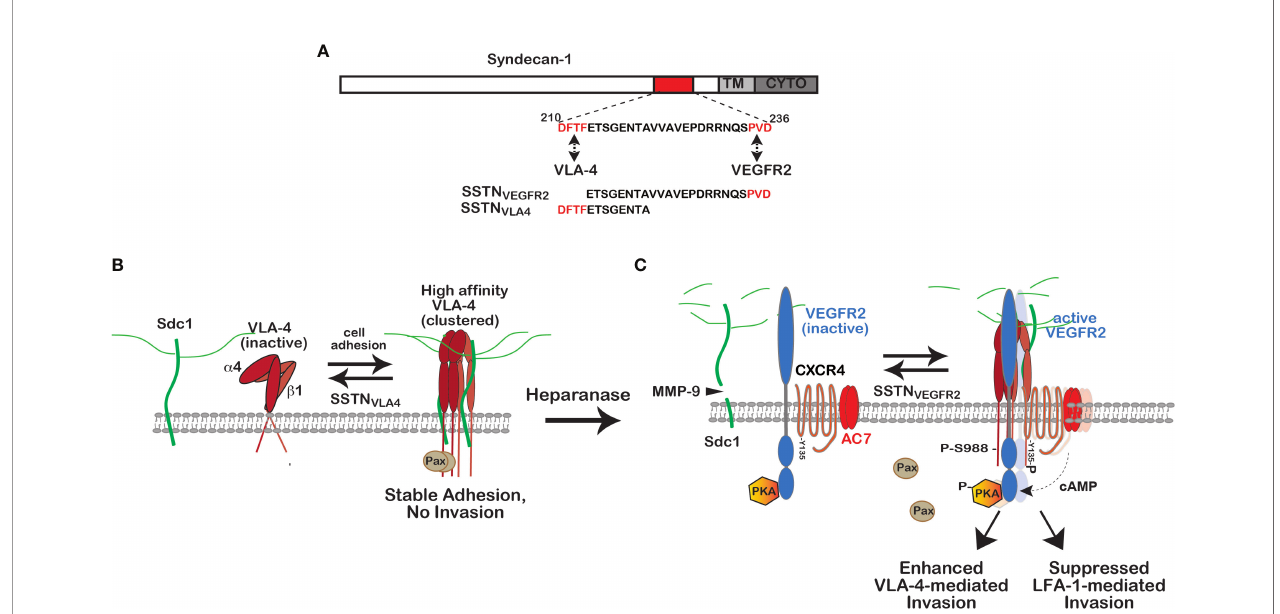
FIGURE 2 | Regulation of VLA-4 activation and polarized cell invasion by Sdc1. (A) VLA-4 and VEGFR2 docking sites in Sdc1. Juxtamembrane sites in the extracellular domain of human Sdc1 (DFTF and PVD) responsible for engaging very late antigen-4 (VLA-4, a 4 b 1 integrin) and vascular endothelial growth factor receptor-2 (VEGFR2), respectively. Synstatin peptides containing one, but not both of these sites (e.g., SSTN VLA-4 or SSTN VEGFR2 ), prevent VLA-4 or VEGFR2 capture by the syndecan and disrupt signaling that relies on the co-capture of both receptors. (B) Regulation of high af fi nity VLA-4 adhesion by Sdc1. VLA-4 undergoes rapid activation when engaging ligand, involving a conformation change and clustering (avidity modulation) to increase binding af fi nity. On cells expressing Sdc1 (e.g., myeloma cells, vascular endothelial cells, melanoma, Jurkat-T cells), this activation is blocked by preventing VLA-4 docking with Sdc1 using SSTN VLA-4 or mutating the DFTF motif in the syndecan. The mechanism underlying this dependence on the syndecan remains under investigation. (C) Role of heparanase and shed Sdc1 in polarized cell invasion . The heparan-sulfate-degrading enzyme heparanase is a known tumor promoter and enhancer of leukocyte recruitment during in fl ammation. Trimming of the HS chains on Sdc1 exposes its core protein to cleavage by matrix-metalloproteinase-9 (MMP-9), releasing the syndecan ectodomain. The shed syndecan couples an inactive receptor complex consisting of VEGFR2 with inactive protein kinase A (PKA) attached to its cytoplasmic domain, the cytokine receptor CXCR4 and adenylate cyclase 7 (AC7) to the clustered integrin, causing VEGF-independent activation of VEGFR2; VEGFR2 phosphorylates CXCR4 on Y135, activating its G a i bg GTPase and the G a i -dependent AC7. Local generation of cAMP leads to activation of protein kinase-A (PKA) engaged with the VEGFR2 cytoplasmic domain and phosphorylation of the a 4-integrin cytoplasmic domain on serine 988. This displaces the Rac-inhibitory paxillin from the integrin, causing polarized invasion of VLA-4-dependent immune cells, typically tumor supporting cells such a macrophages, MDSCs and others, as well as myeloma cells. Displacement of paxillin also inhibits the cross-talk between VLA-4 and LFA-1 necessary for LFA-1-mediated migration that characterizes tumor suppressor cells, such as NK and cytotoxic T cells. Either prevention of integrin activation by SSTN VLA-4 or VEGFR2-coupling to the integrin by SSTN VEGFR2 serves to block these processes [see discussion in text, references (60, 64) and references